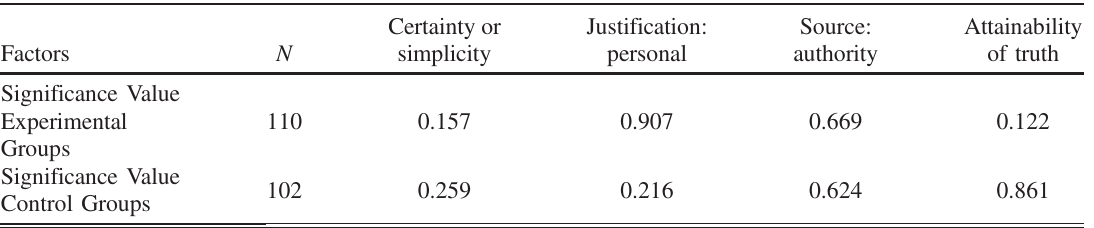
TABLE XV. The results for the test of homogeneity of variance between the groups taught by the student author and the groups taught by another lab